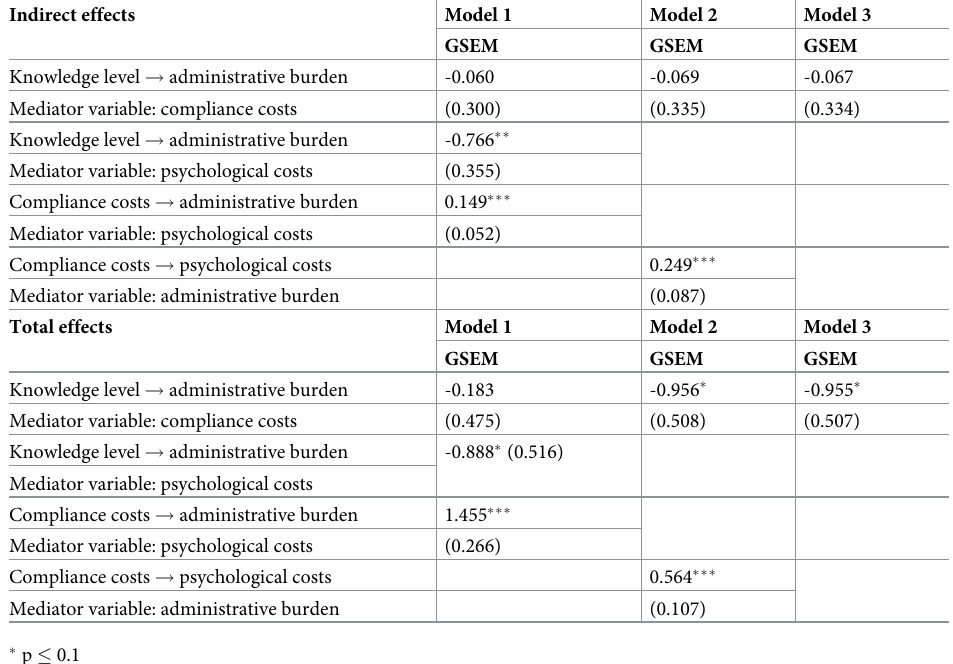
Table 4. Indirect and total effects of the (causal) structural model (unstandardized